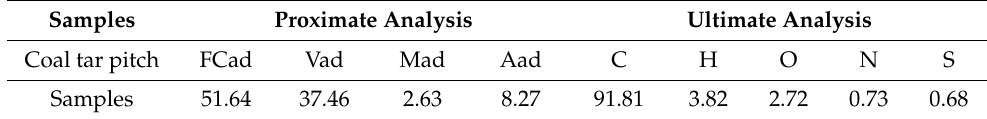
Table 3. Proximate and ultimate analyses of coal tar pitch